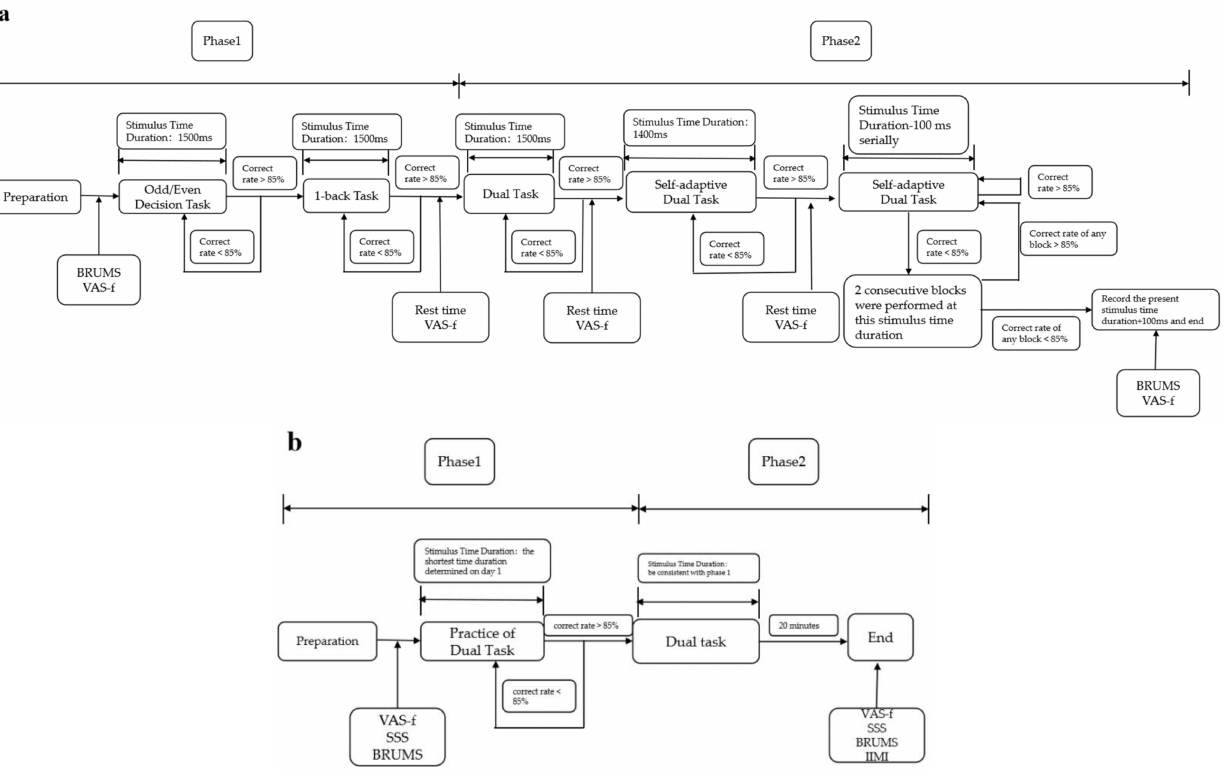
Figure 2. Flowchart of the improved version of the TloadDback task: ( a ) flowchart of day 1; ( b ) flowchart of day